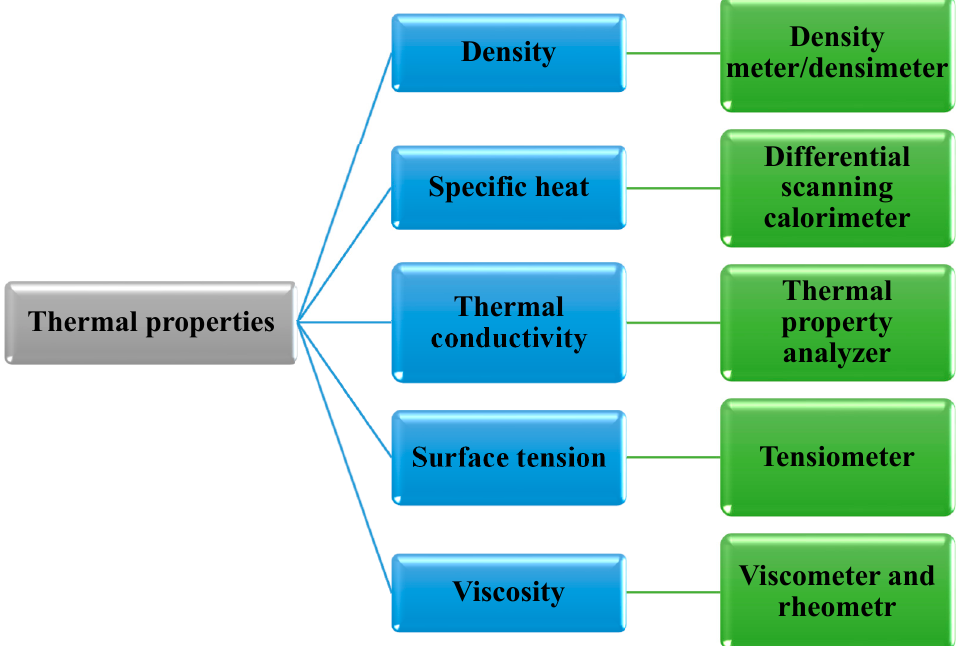
Figure 16. Instruments for measuring different thermal properties of nanofluid.